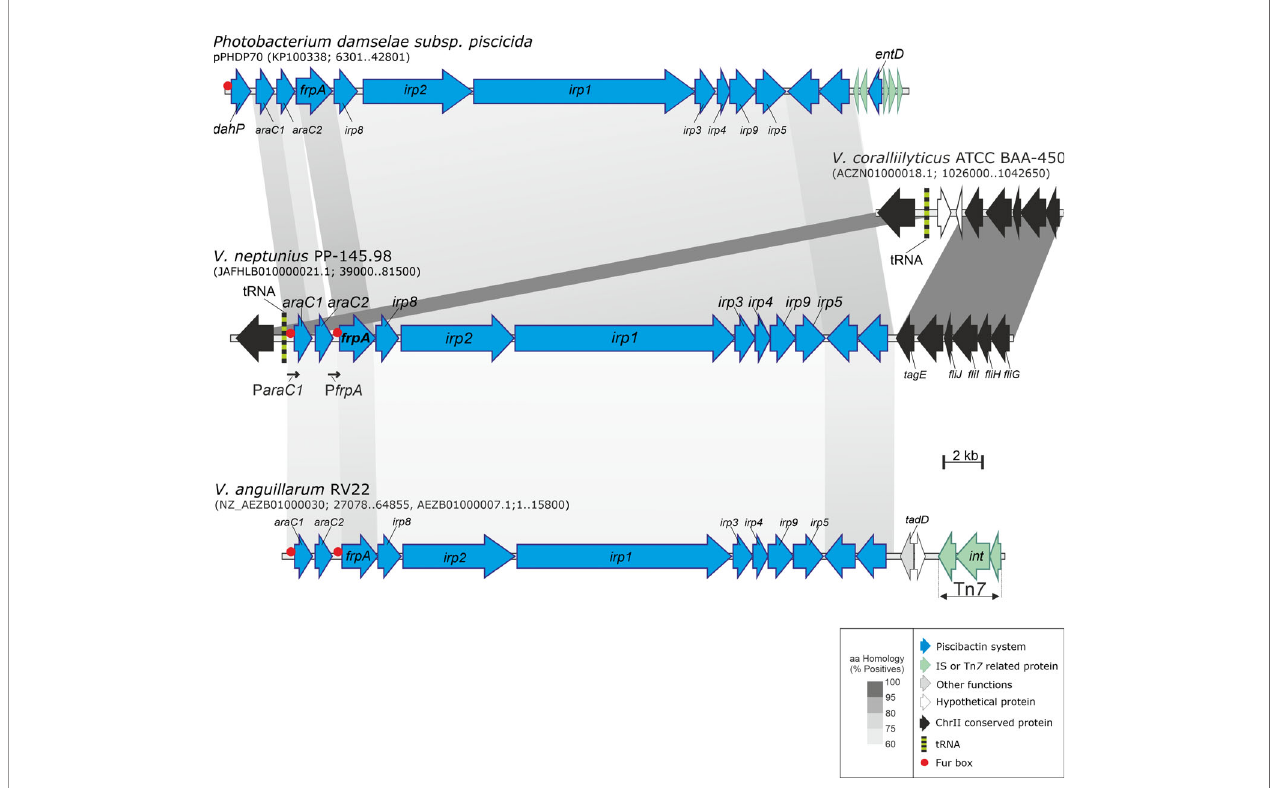
FIGURE 1 | Genetic map of the gene cluster encoding the piscibactin system in V. neptunius. The piscibactin genes, which are part of V. angullarum RV22 chromosome II and the plasmid pPHDP70 of P. damselae subsp. piscicida are included for comparative purposes. Grey blocks indicate percentages of similarity in the proteins